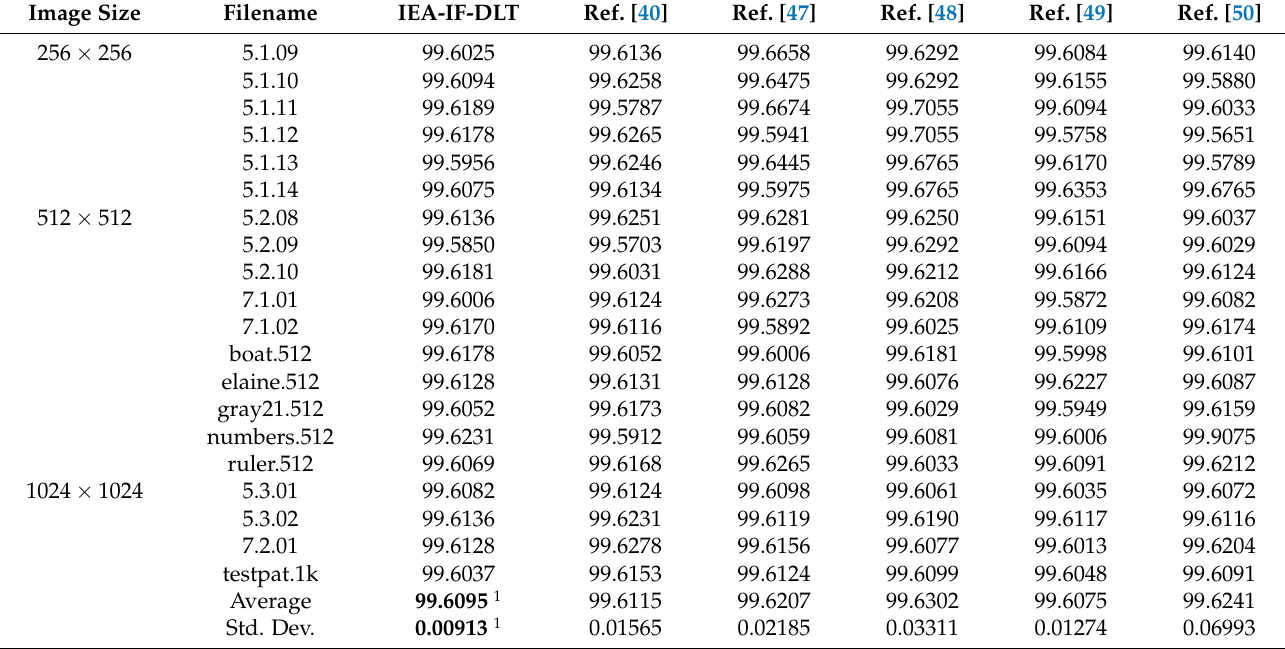
Table 3. NPCR test results of IEA-IF-DLT and other image encryption algorithms.